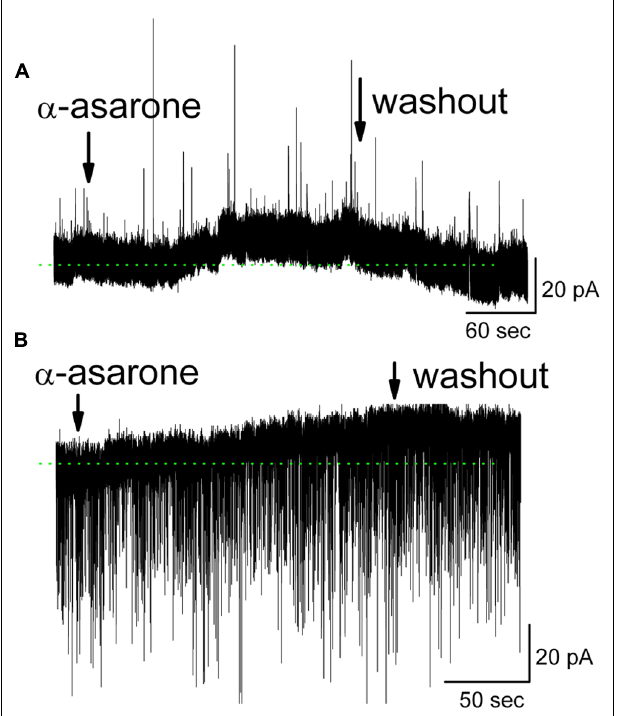
FIGURE 6 | α -Asarone induced outward currents in MCs. (A) Original recording from a MC illustrates an outward current induced by 20 μ M α -asarone. Low-Cl − pipette solution containing sodium channel blocker QX-314 was used, and holding potential is 0 mV. (B) α -Asarone induced an outward current in MC with high-Cl − pipette solution containing QX-314. Holding potential is at − 60 mV. sIPSCs appear as downward deflections. The dotted green lines indicate the zero-current